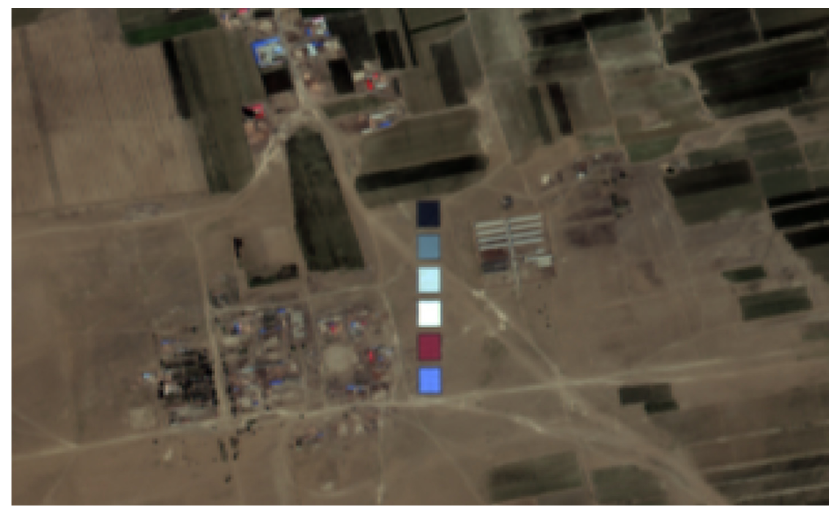
Figure 3. The laboratory measured BRF of the calibration tarps.